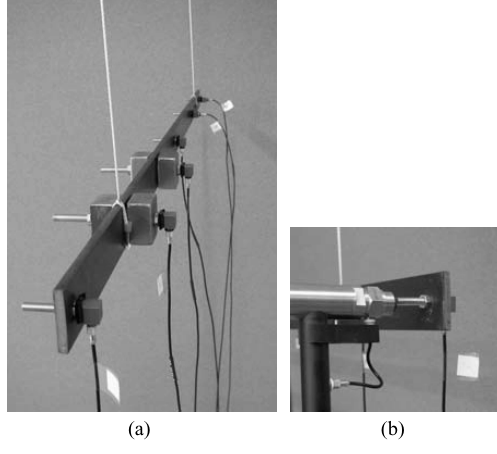
Fig. 3. System with mass modification (mass addition).